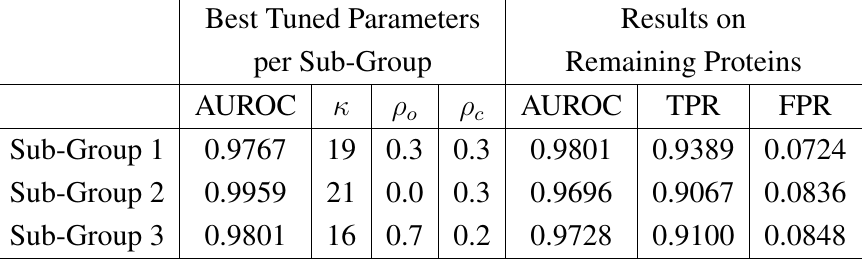
) for each ρ . Each of the three curves corresponds o c